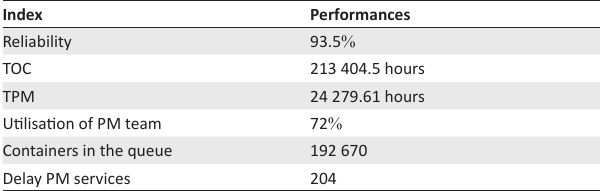
TABLE 10: Outcomes of longer shifts for preventative maintenance technicians.